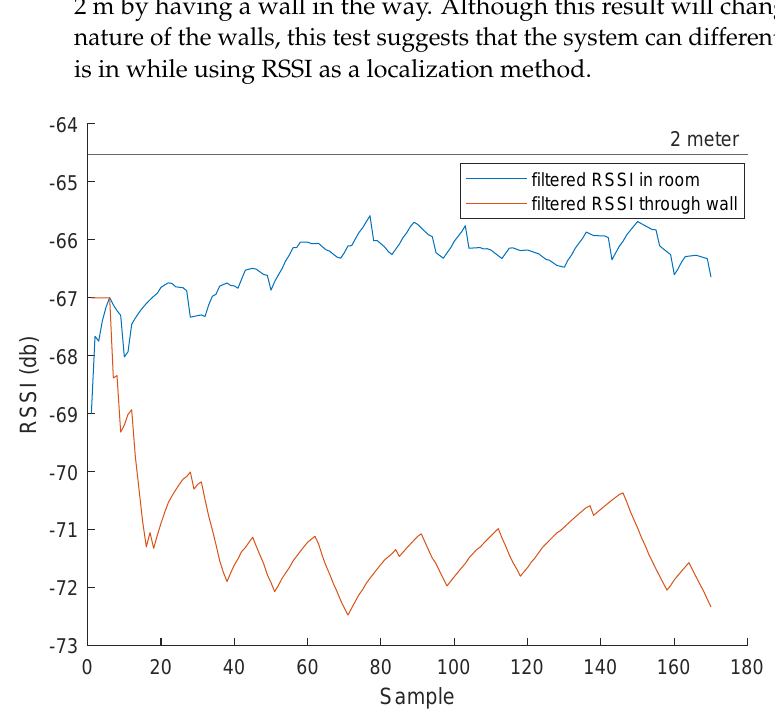
Figure 16. The effect of the wall on RSSI at 2 m.